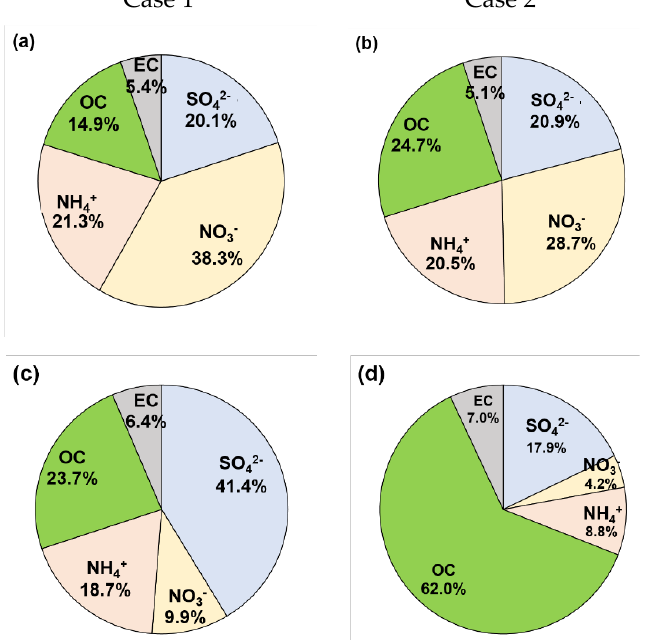
Figure 7. Average relative contributions to PM 2.5 mass at JB-IAMS ( a , b ) and JJ-IAMS ( c , d ) for Case 1and Case 2, respectively. Table 3. Summary of PM 2.5 components SO 42− , NO 3− , NH 4+ , OC, EC, and the OC/EC ratio during Case 1 and Case 2 at JB-IAMS and JJ-IAMS.